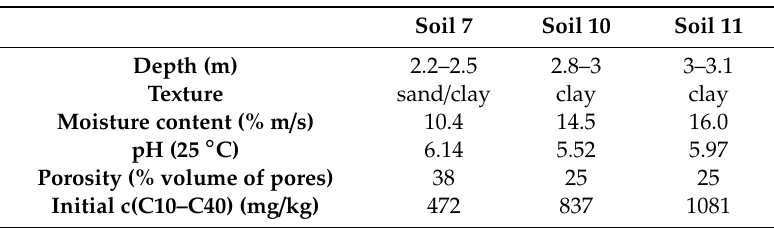
Table 6. Properties of the tested soils samples.